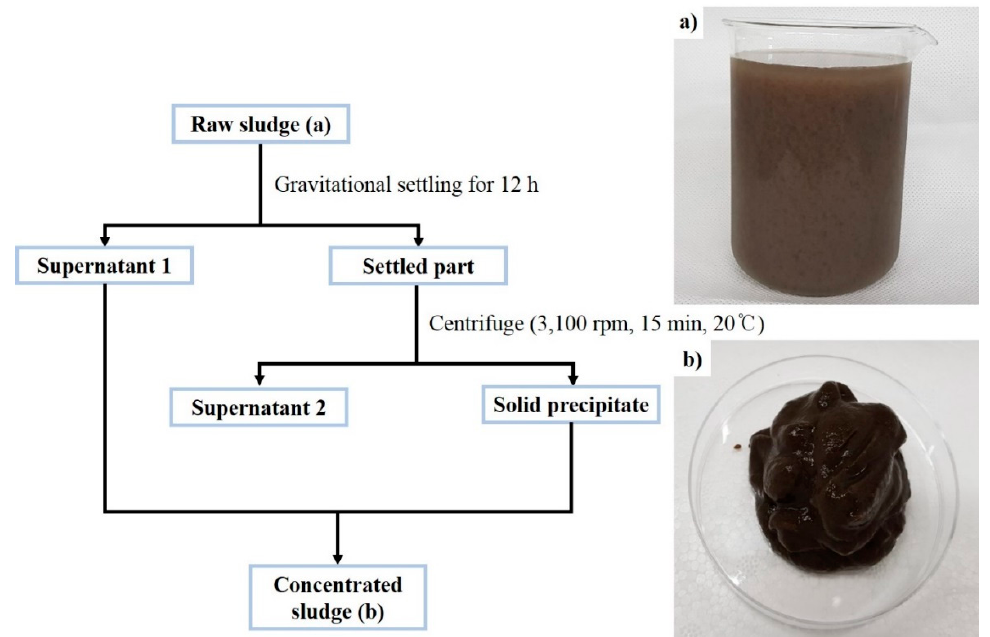
Figure 1. Scheme for preparation of the sewage sludge sample: ( a ) raw activated sewage sludge; ( b ) concentrated sludge.